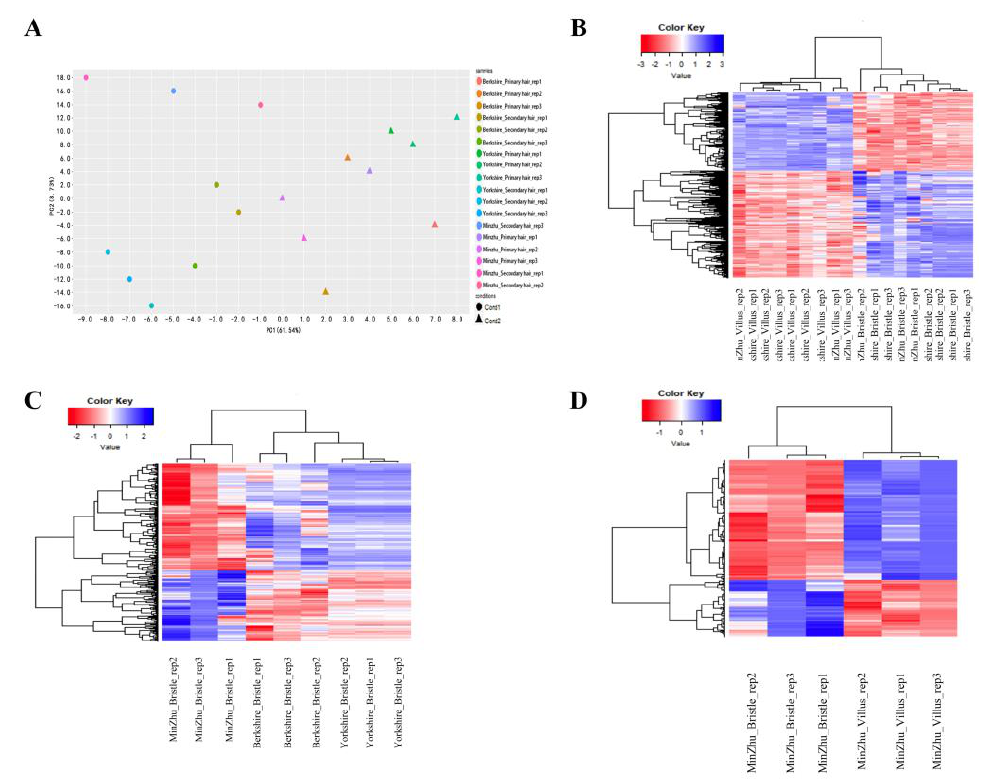
Figure 3. The study compared the gene expression in the primary hair and hair follicle tissues from three pig breeds with high-throughput sequencing. Hierarchical cluster analysis of gene expression based on mRNA sequencing data. A Principal component analysis of gene expression in skin and follicle tissues in three breeds. ( A ) The PCA clusterization successfully separated hair follicle tissues from primary hair and secondary hair samples, and the samples are plotted across the two most variable components (PC 1and PC 2). Cond 1 and Cond 2 represent the secondary and primary hairs, respectively. ( B , D ) Gene clustering is rather based on primary hair and secondary hair tissues. The expression values for each gene are arranged in the heat map. ( B ) The primary hair and hair follicle tissues from the Min pig, Yorkshire pig, and Berkshire pig were compared with the gene expression. ( C ) The primary hair follicle tissues from the Min pig, Yorkshire pig, and Berkshire pig were compared with the gene expression. ( D ) The primary hair and hair follicle tissues of Min pigs were compared with the gene expression. Blue indicates the genes with greater expression, and red indicates the genes with lower expression.